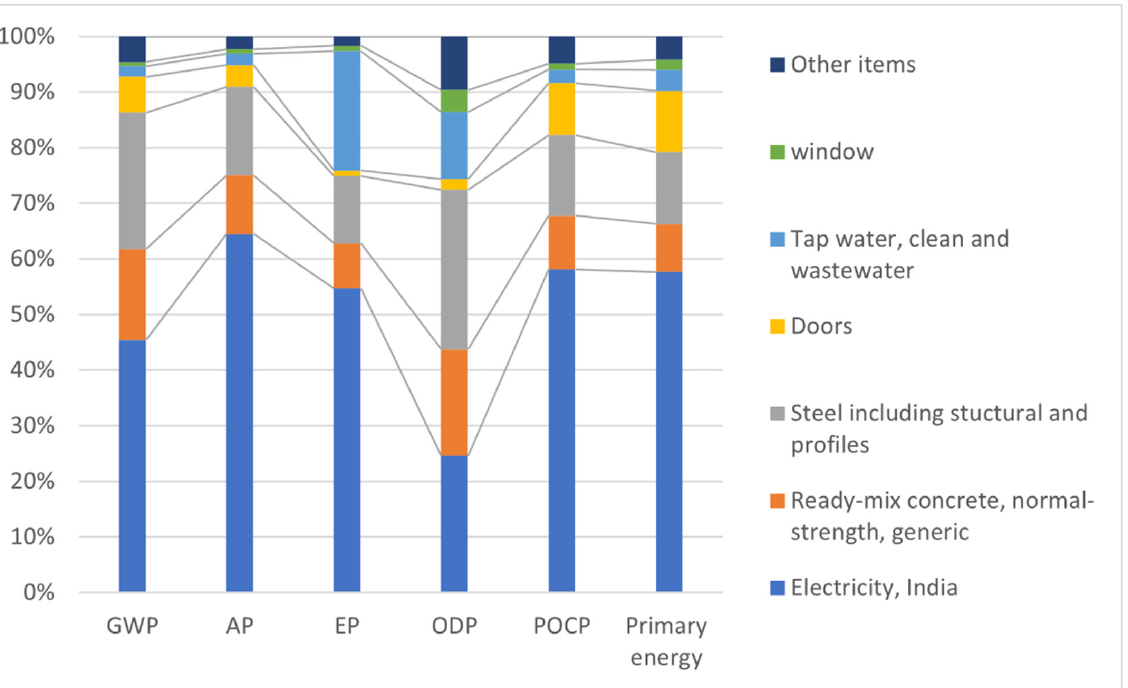
1.20E+07 Figure 4. Embodied carbon based on life cycle stages. 0.00E+00 2.00E+064.00E+066.00E+06 8.00E+06 1.00E+07